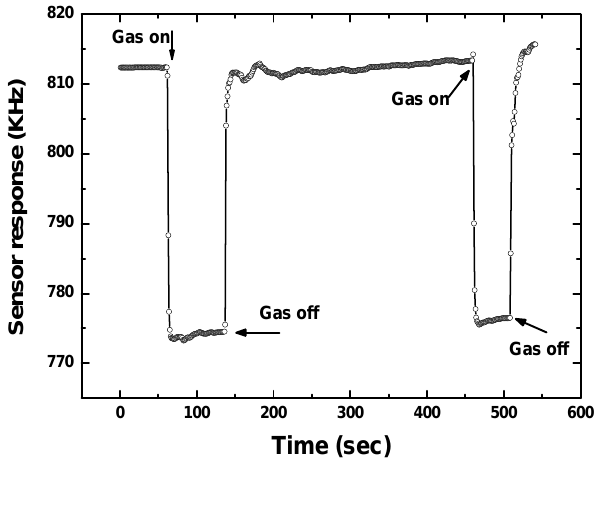
Figure 10. Repeatability testing of sensor responses to 1,000 mg/m 3